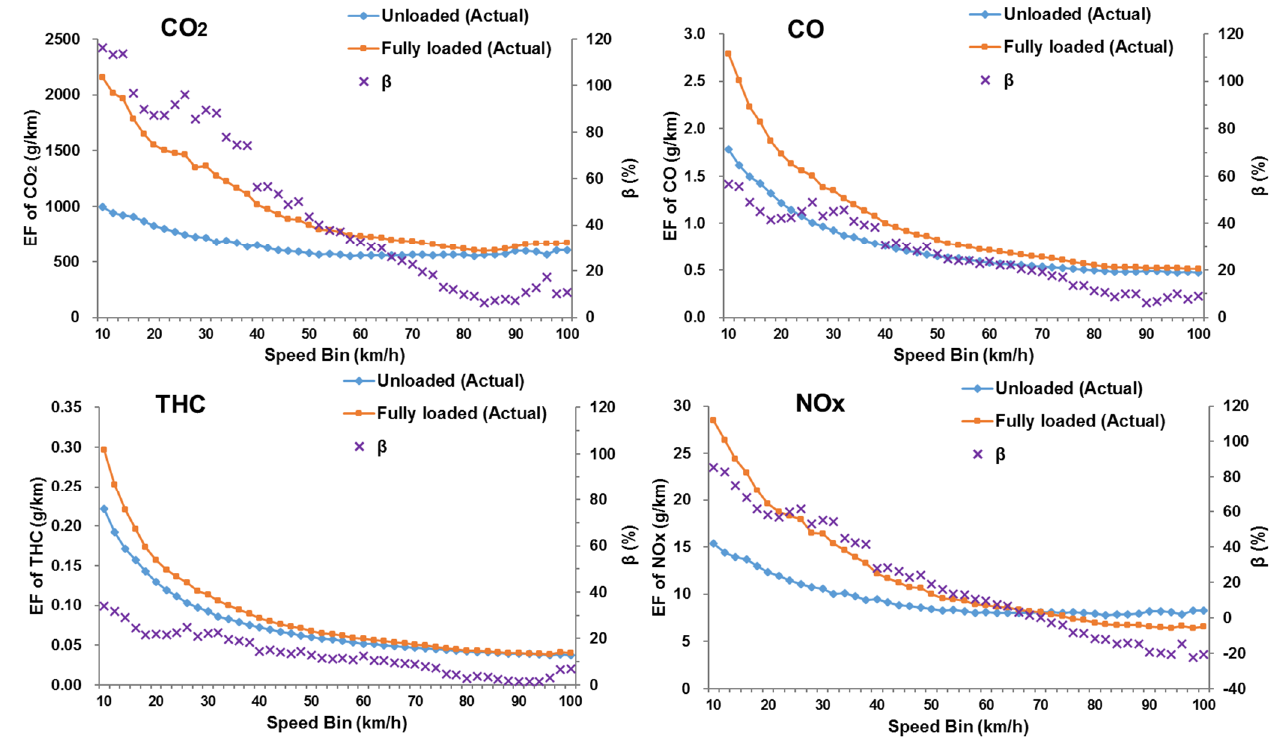
Figure 8. The emission factor differences of CO 2 , CO, THC and NO x between fully loaded and unloaded status in each speed bin.